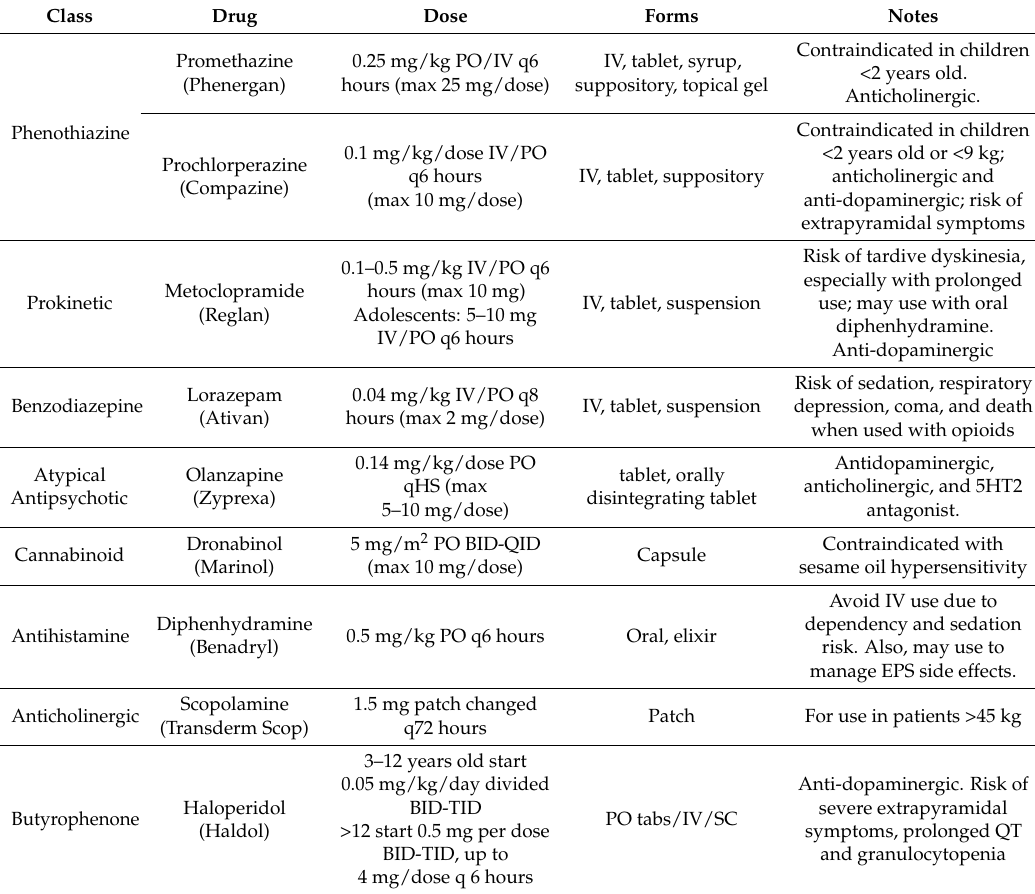
Anti-dopaminergic. Risk of severe extrapyramidal symptoms, prolonged QT and